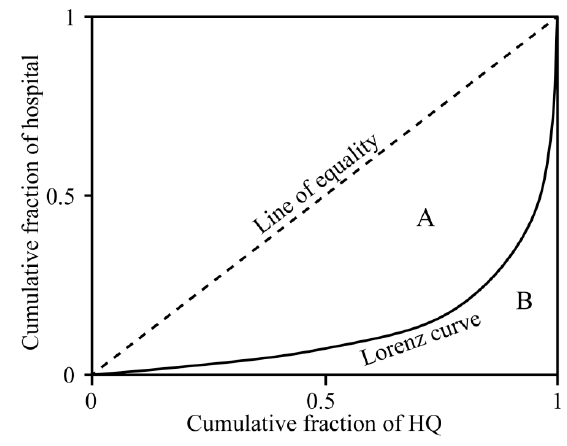
Figure 2. Lorenz curve diagram.